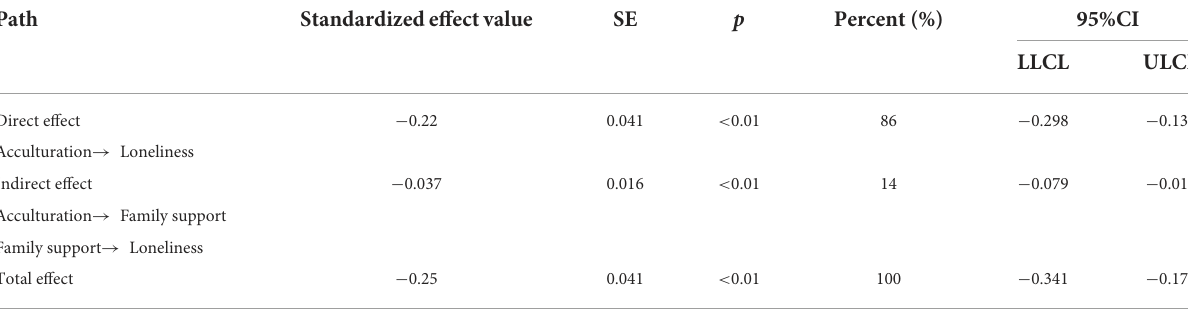
TABLE 4 The standardized total, direct, and indirect effects of acculturation on loneliness with family support as mediators ( N =